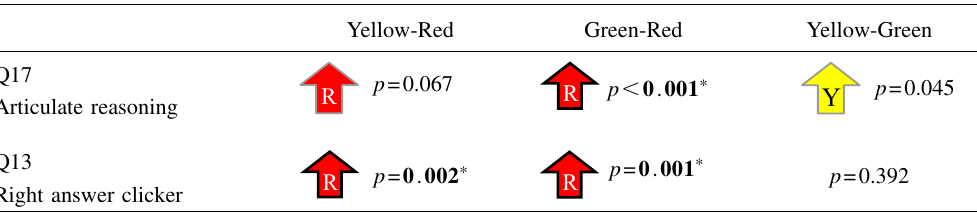
TABLE V. (cid:1) Color (cid:2) Mann-Whitney U Test Results for Pairwise Comparisons on Sense-making Survey Questions. The arrows in the table indicate which group tends to yield higher (cid:1) more favorable (cid:2) responses for all p -values less than 0.1. Bold font (cid:1) with astrik (cid:2) indicate statistically significant